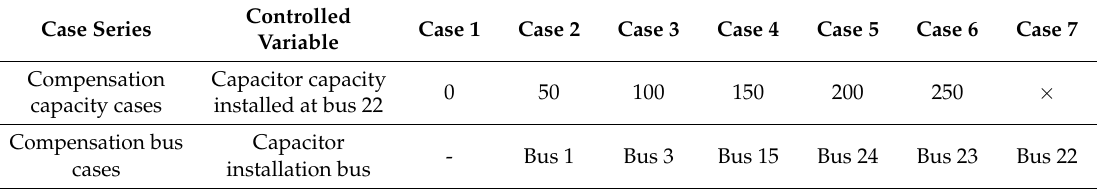
Table 1. Two case series designed for the New England 39-bus system.